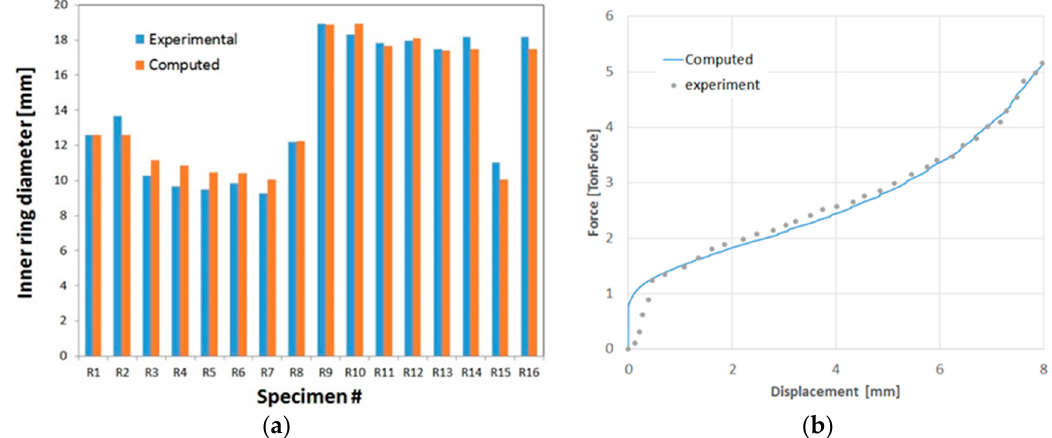
Figure 11. Comparison between computed and measured inner ring diameter for experiments R1-R16 ( a ) and an example of a computed and measured force-displacement curve for specimen R15 ( b ).